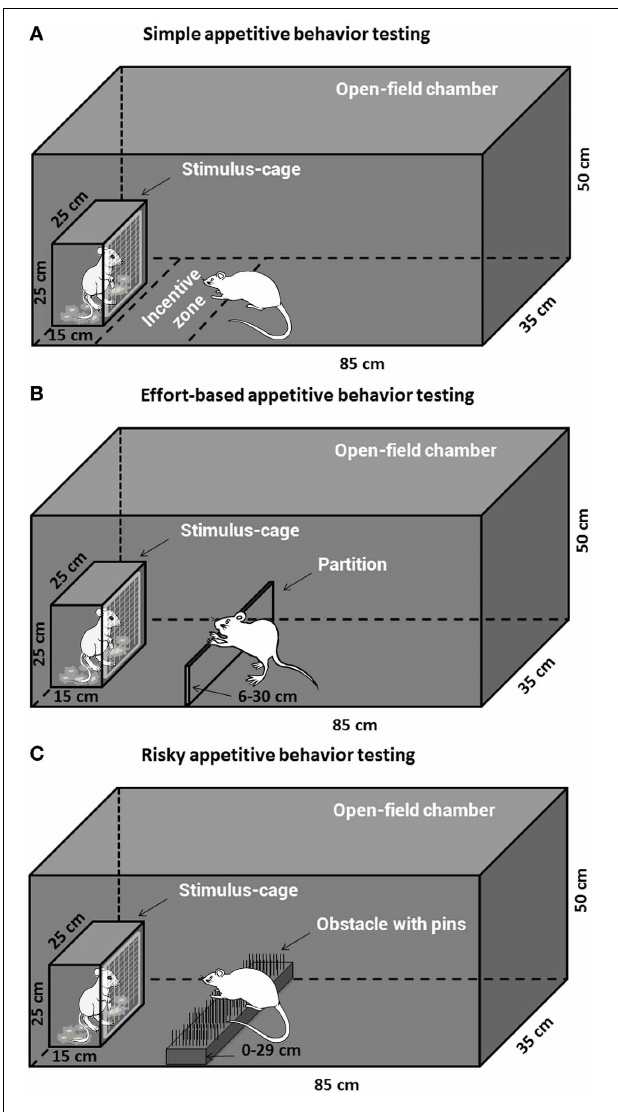
FIGURE 1 | The apparatus for the social or sexual appetitive behavior testing in male rats. The open-field chamber with a stimulus-cage holding a male or estrous female rat could be adapted to different appetitive behavior testing tasks. (A) The subjects could freely approach and investigate the incentive rat inside the stimulus-cage during the simple appetitive behavior testing. (B) The subjects had to expend labors, i.e., climb over a continuously heightened partition, to approach the stimulus-cage during the effort-based appetitive behavior testing. (C) The subjects had to surmount a dangerous obstacle, i.e., climb over a continuously heightened board thick with pins, to approach the stimulus-cage during the risky appetitive behavior